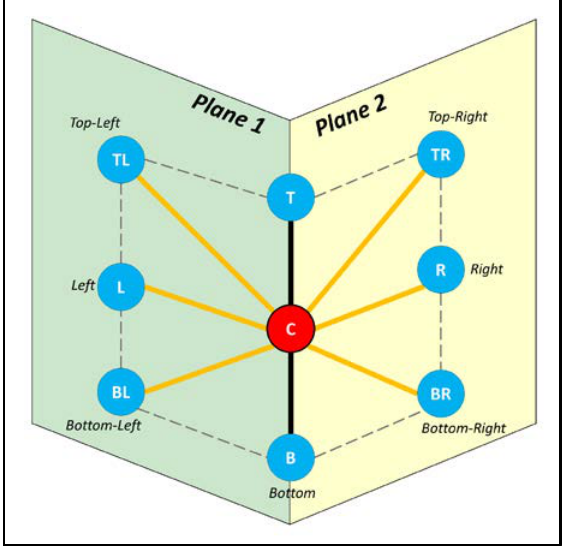
Figure 2. Edge detection based on normal variation analysis: Point C (red) is the center point being analyzed with neighbors (blue) in the grid data structure; Points T , C , and B technically lie on the intersection of Plane 1 and Plane 2 (hence, on both planes), while the other points lie on only one of the